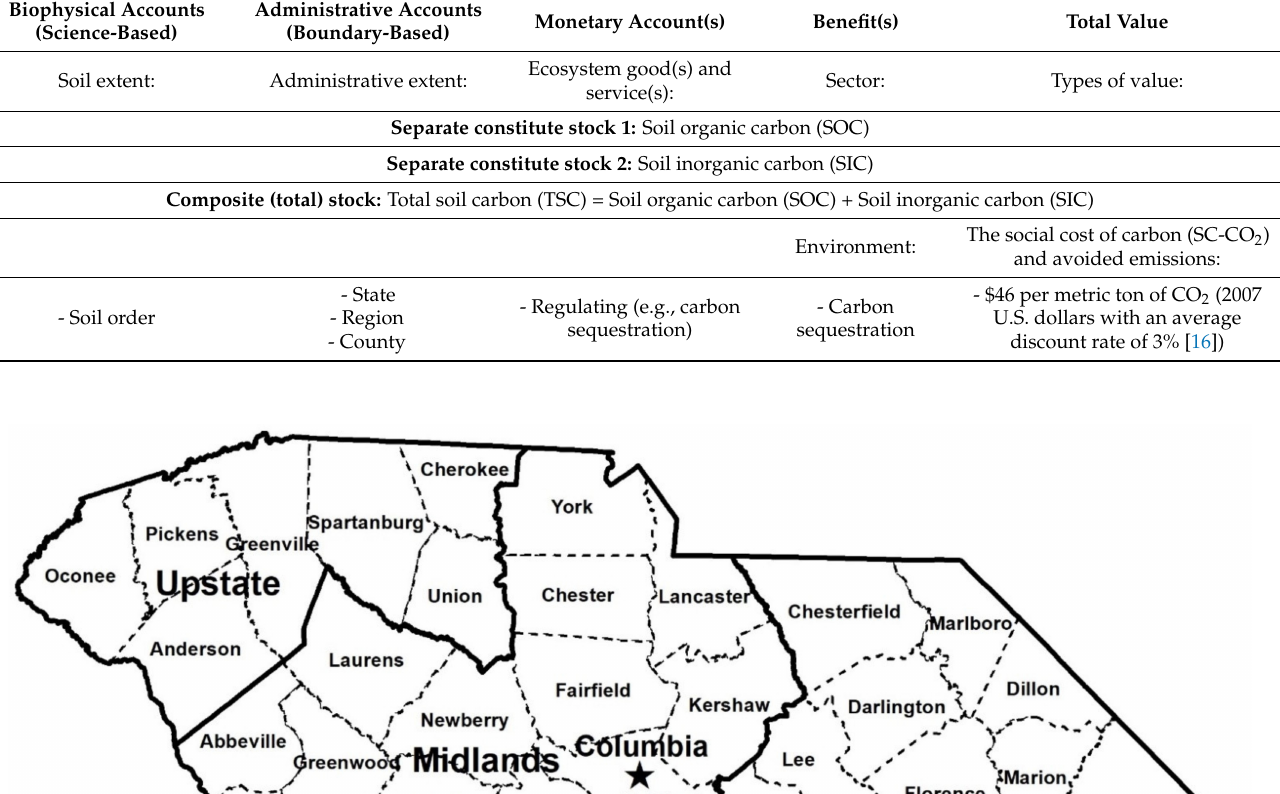
Table 2. A conceptual overview of the accounting framework used in this study (adapted from Groshans et al., 2018 [19]). Biophysical Accounts (Science-Based)